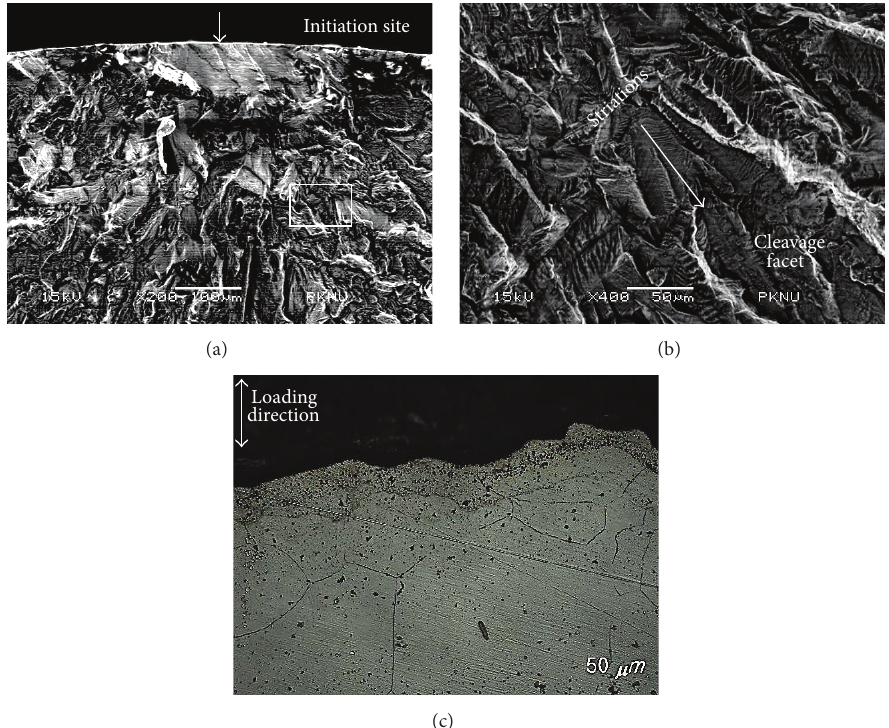
Figure 10: (a) SEM images representing a crack initiation site; (b) typical propagation SEM image showing fatigue striations; and (c) cross- sectional OM image of surfaces for Alloy 617 BM tested at 0.6% total strain